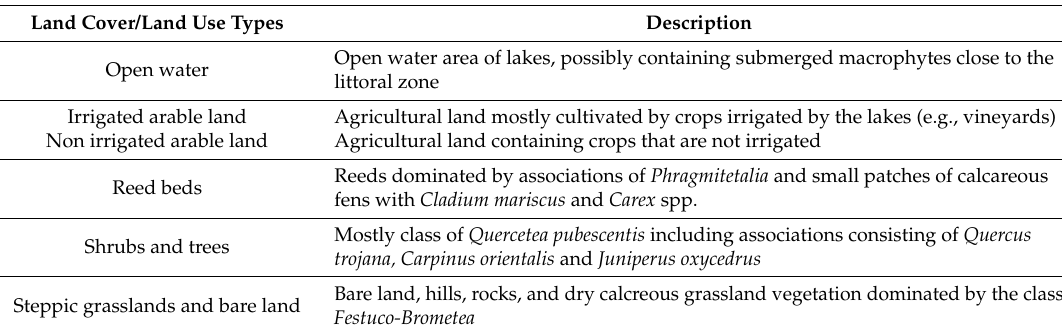
Table 2. Land cover/land use classification system for the studied